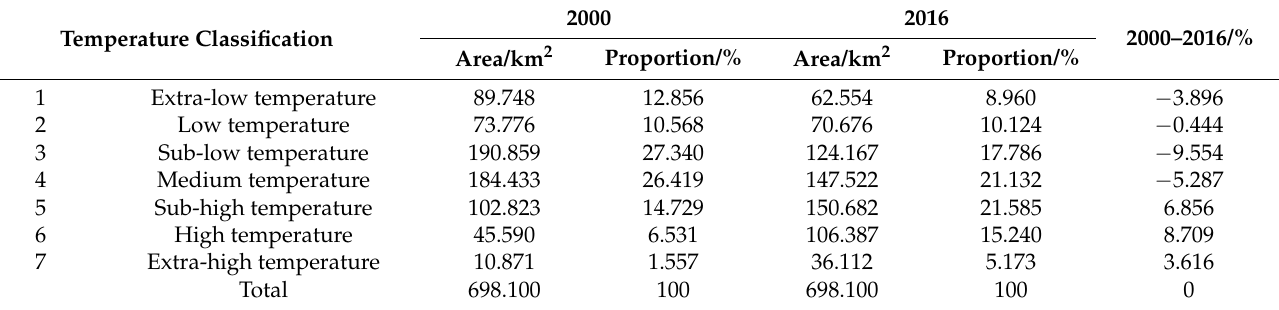
Table 5. Surface average temperature and temperature grade area change from 2000 to 2016.